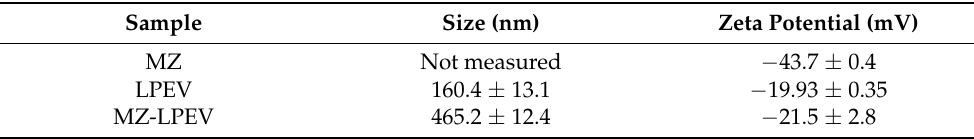
Table 1. Characterization of MZ, LPEV, and MZ-LPEV. Hydrodynamic size (Mean diameter, nm) from NTA analysis and zeta potential values were shown. Data are presented as mean ± standard deviation ( p < 0.05).